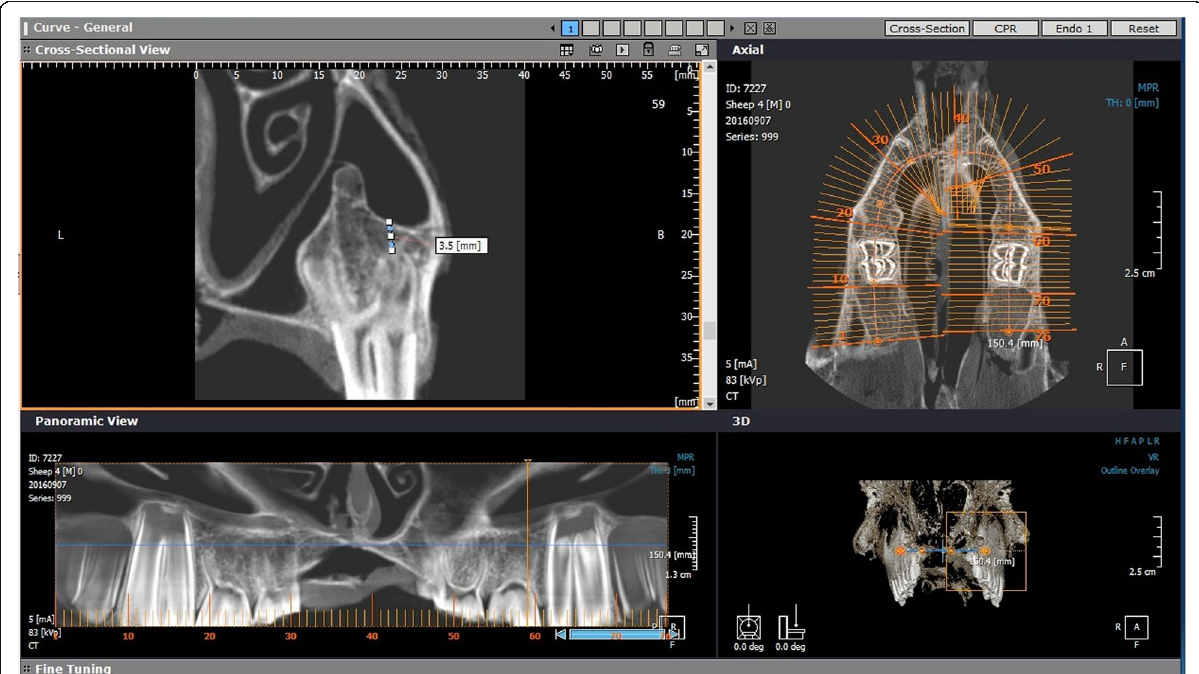
Fig. 1 Determination of the remaining bone height (RBH) on the CBCT